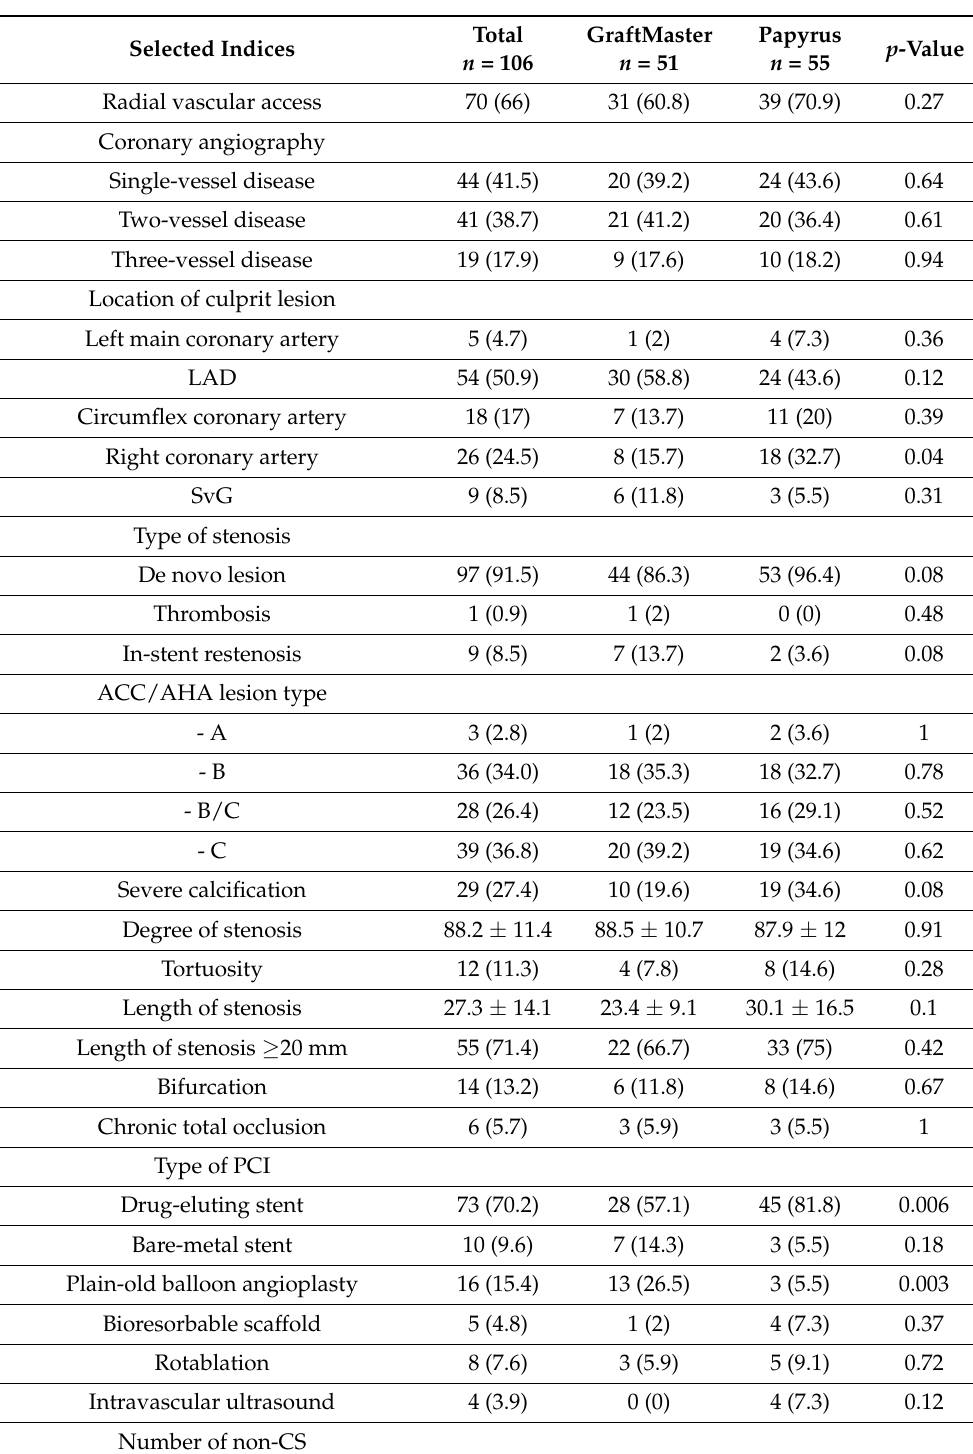
Table 2. Coronary angiography and culprit lesion